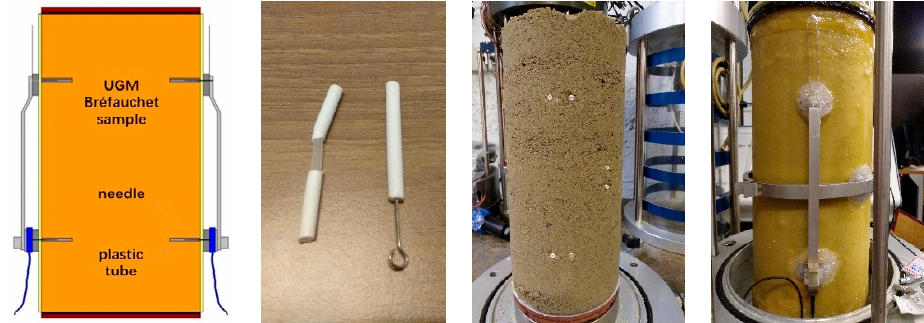
Figure 9. Fixing three displacement transducers with tubes.